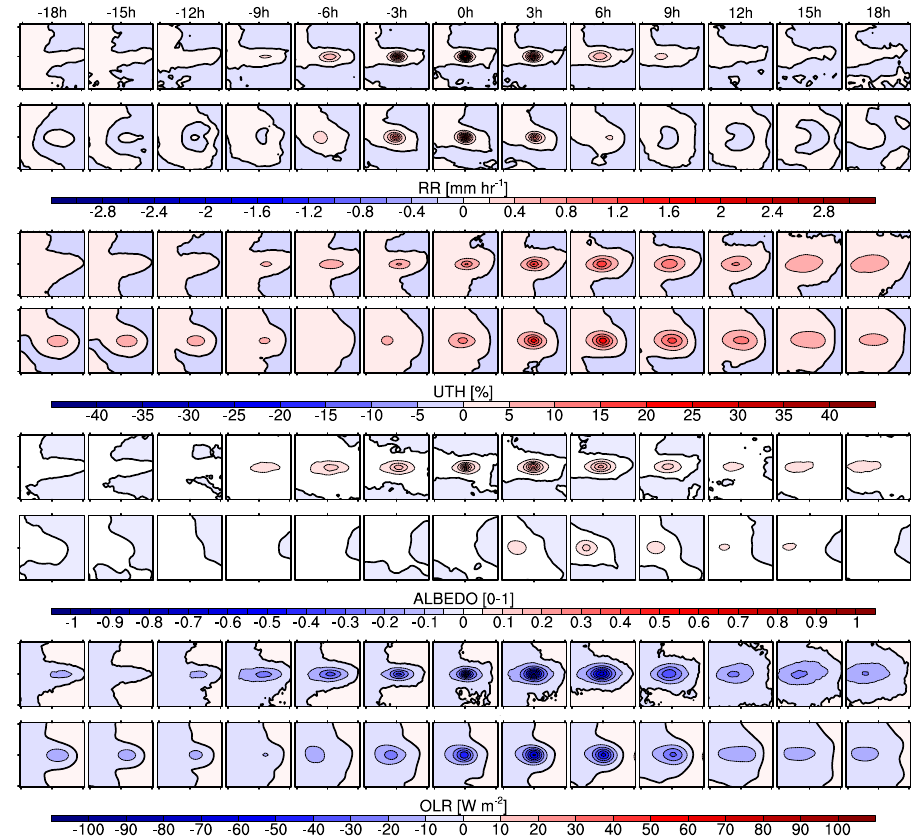
Fig. 4. Anomaly friezes for RR, UTH, albedo, and OLR. All other aspects of the figure are as Fig. 3. The zero line is indicated by a bold line.